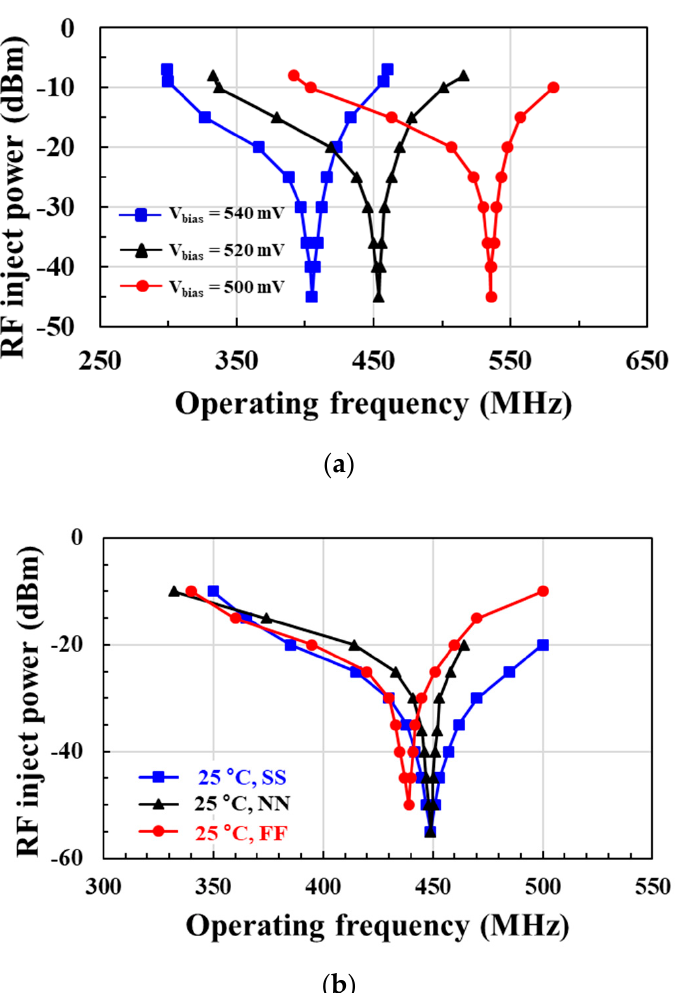
Figure 12. Locking range and sensitivity at ( a ) different V bias and ( b ) different corner models and temperature combinations.